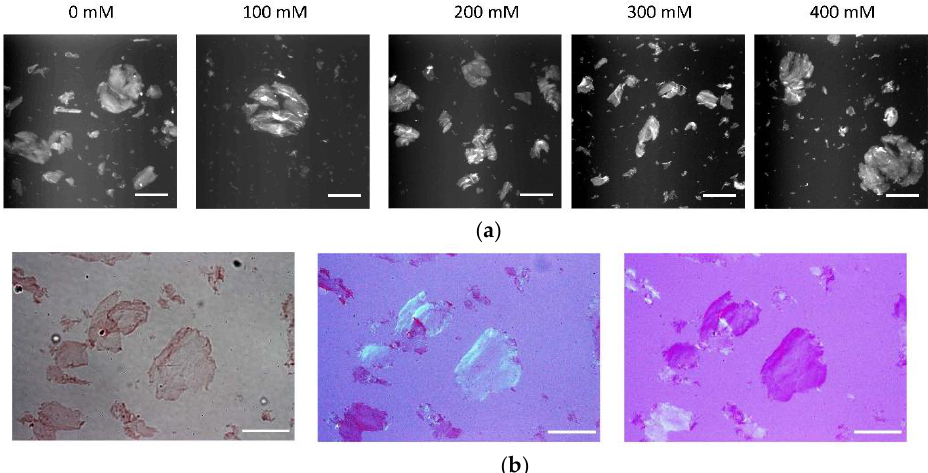
Figure 3. Two-dimensional fibril plaques formed at pH 7. ( a ) Fluorescence images of ThT-stained hewL fibril sheets following transfer to pH 7. pH transfer induces self-assembly into two-dimensionsal fibril plaques at all salt concentrations . Scale bar: 200 μ m. ( b ) Fibril sheets stained with 50 μ M Congo red (left panel) and imaged with crossed polarizers in two slightly different orientations (middle and right). Scale bar: 100 μ m.